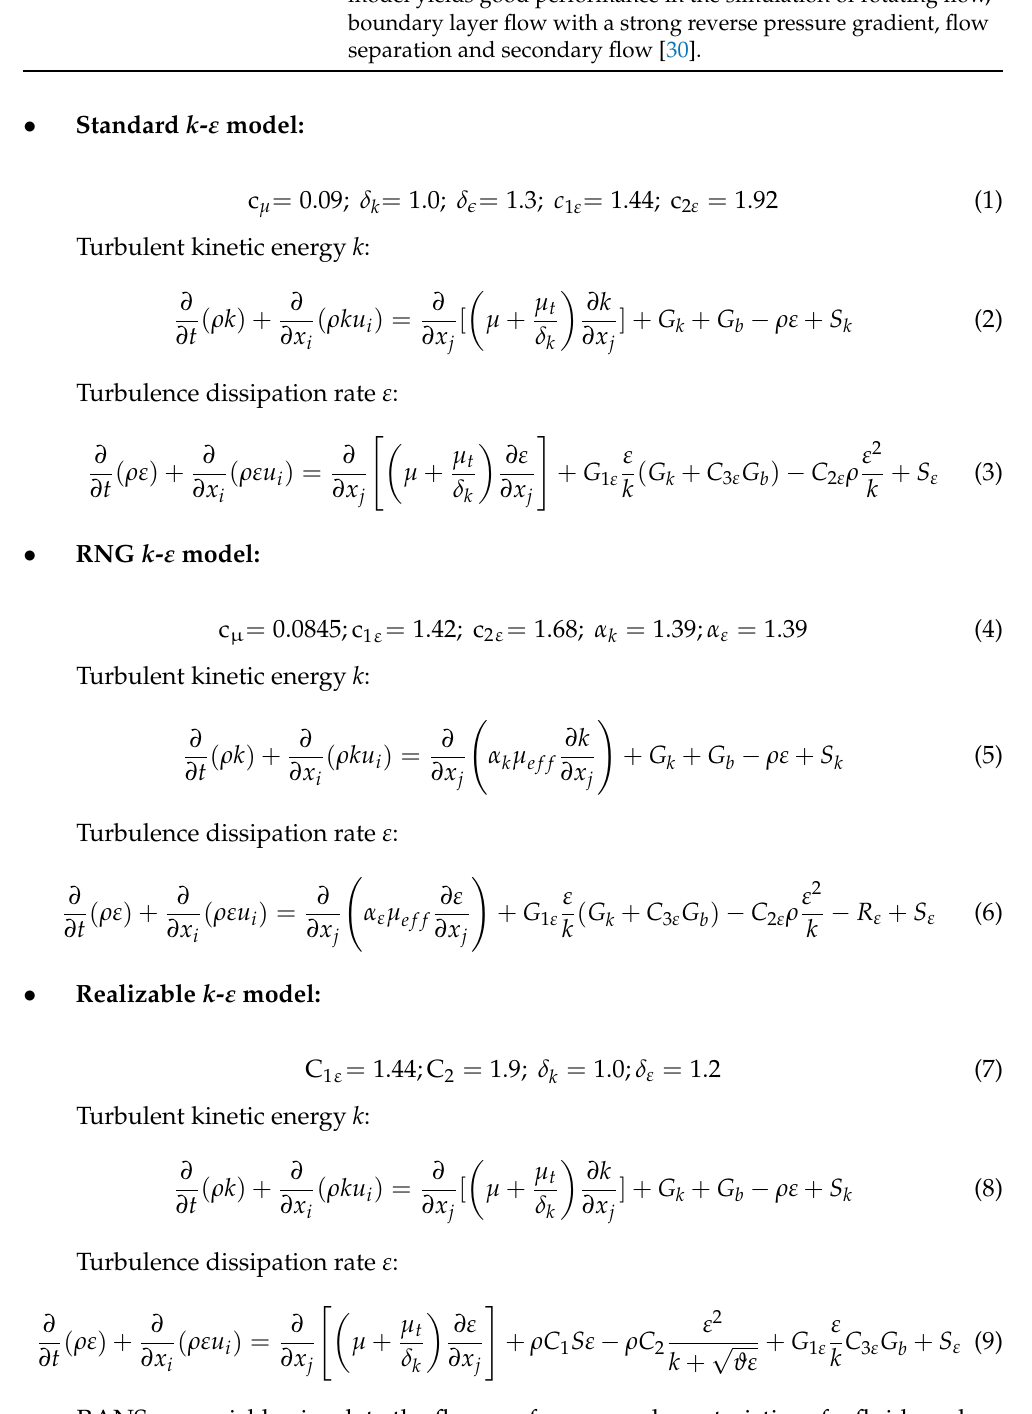
Table 2. Cont. k - ε Models Difference and Usage This model is almost the same as the RNG k - ε model and can also be used to simulate the circular hole jet problem. The prediction of the divergence ratio of flat and cylindrical jets is more accurate Realizable k - ε with this model than with the RNG model. Additionally, this model yields good performance in the simulation of rotating flow, boundary layer flow with a strong reverse pressure gradient, flow separation and secondary flow